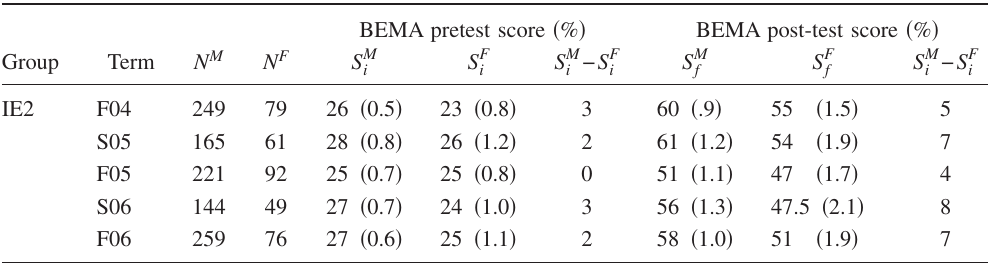
TABLE III. BEMA (cid:1) Ref. 3 (cid:2) data for the second-semester calculus-based physics course at CU; N M (cid:1) F (cid:2) is the number of males (cid:1) females (cid:2) for whom there are matching BEMA pre- and post-test data; S iM (cid:1) F (cid:2) is the average pretest score (cid:1) using the BEMA scoring rubric (cid:2) for males (cid:1) females (cid:2) ; and S f equals the average post-test score. The numbers in parentheses represent the standard error of the mean. S iM − S iF equals the gender gap.